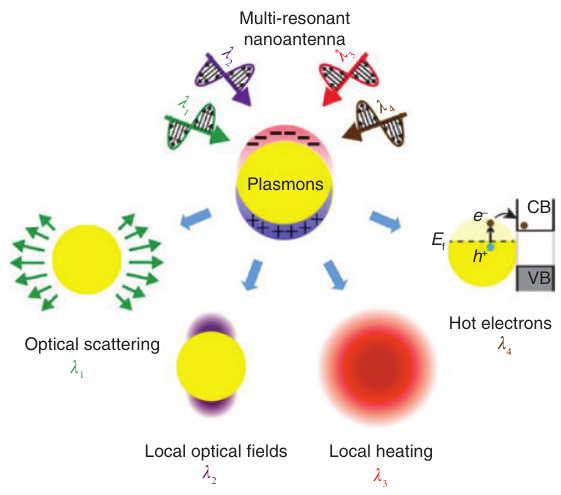
Figure 12: Schematic illustration of the wavelength-multiplexed nanoplasmonic system concept, i.e. merging several different types of plasmonics enabled/enhanced modalities into the same nanoscale device by using different wavelength